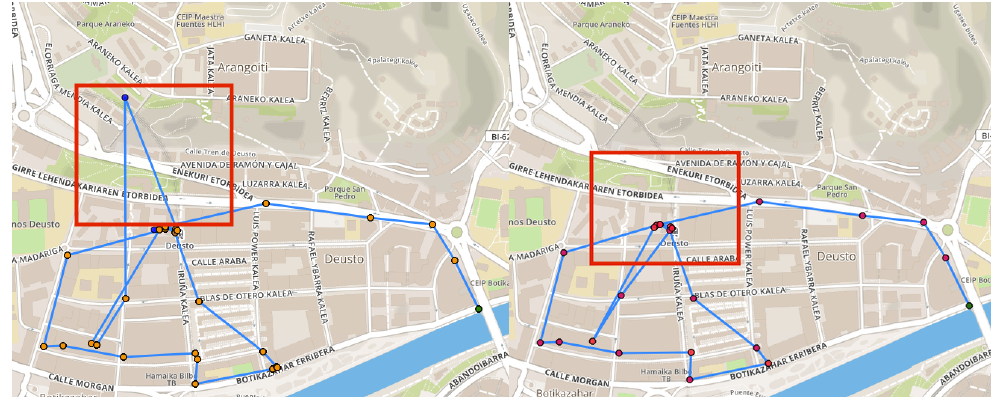
Figure 1. Example of how a GPS drift would be removed. On the left the original drift, on the right the drift already